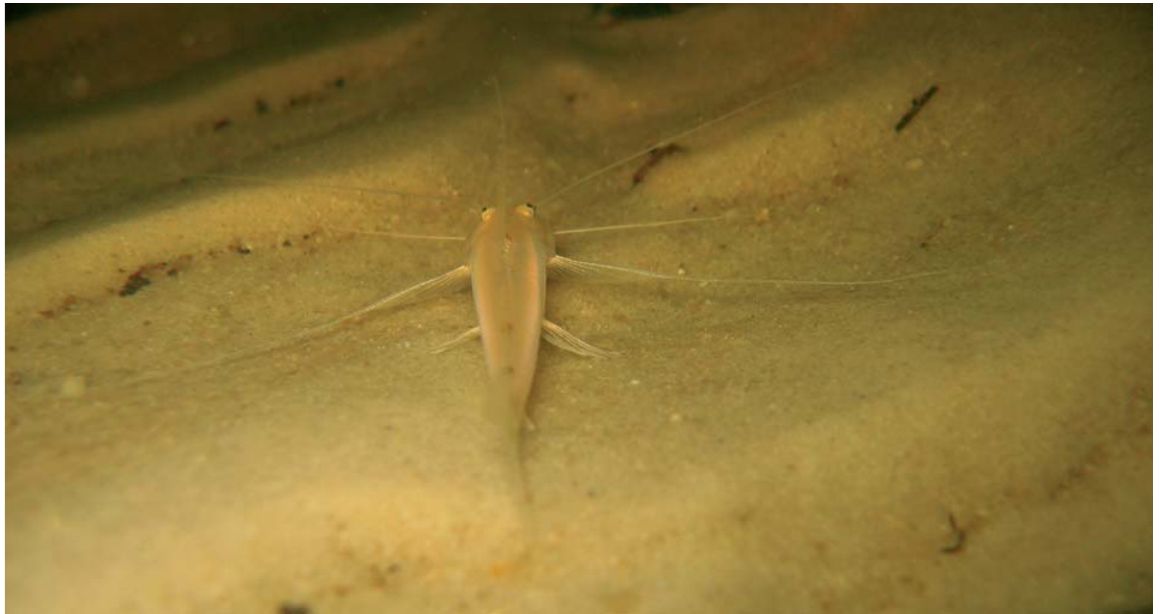
Fig. 2 . The sit-and-wait foraging posture of Mastiglanis asopos in posterior view. Note very long barbels and filamentous rays of pectoral fins spread in a drift trap-like device, as well as the alignment of mentonian barbels and pectoral filaments.